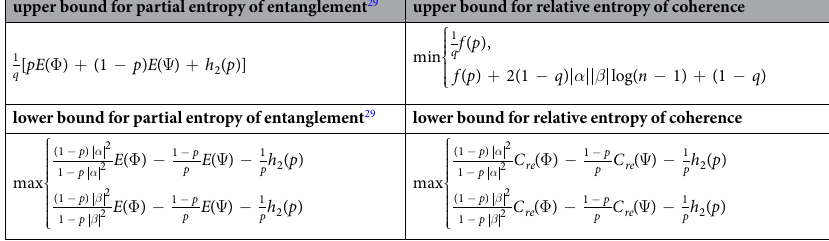
Table 1. Comparison between bounds on partial entropy of entanglement and relative entropy coherence for the superposition of two orthogonal states (Here φ φ φ = E S Tr ( ) ( ) AB state φ AB 28 ).